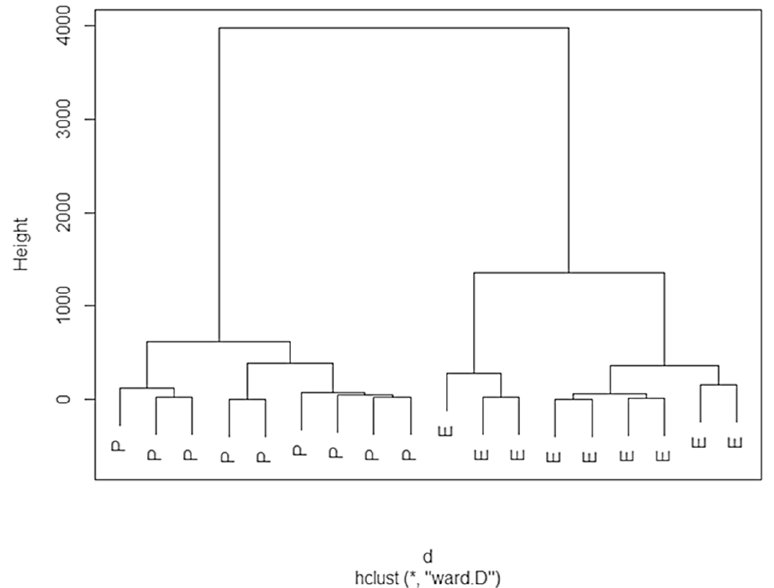
Figure 4. Dendrogram obtained by a cluster analysis of the two rosemary varieties. P—“Prostatus”, E—“Erectus”.